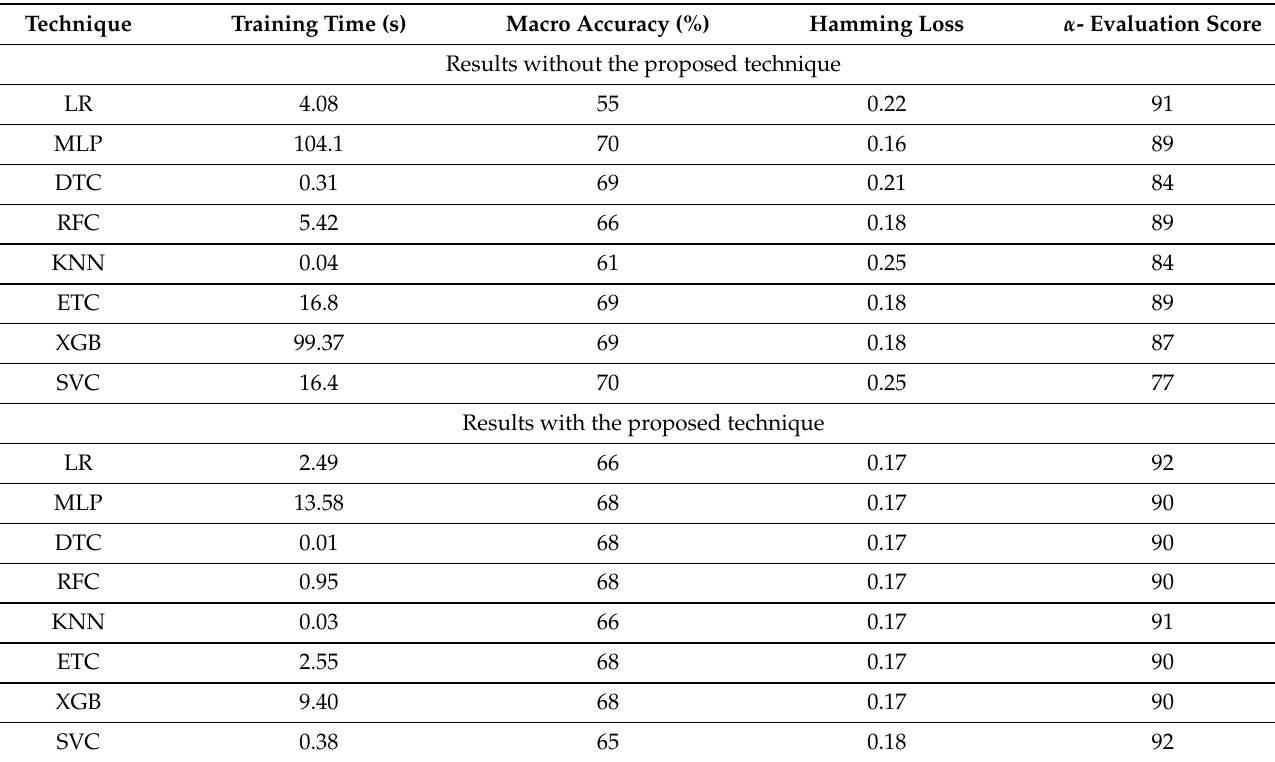
Table 9. The multi-label multi-class performance comparative analysis with an imbalanced dataset using a data split of